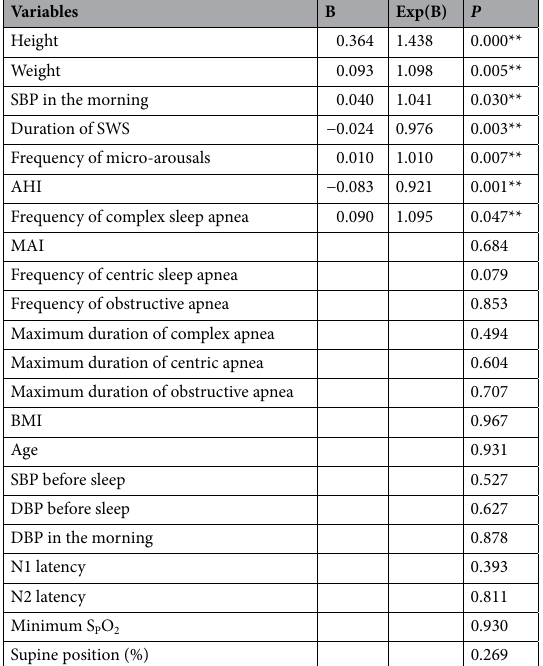
Table 4. Multivariate logistic regression analysis of gender differences of clinical and polysomnographic findings with OSAS. MAI microarousal index, AHI apnea–hypopnea index, SWS slow wave sleep, TST